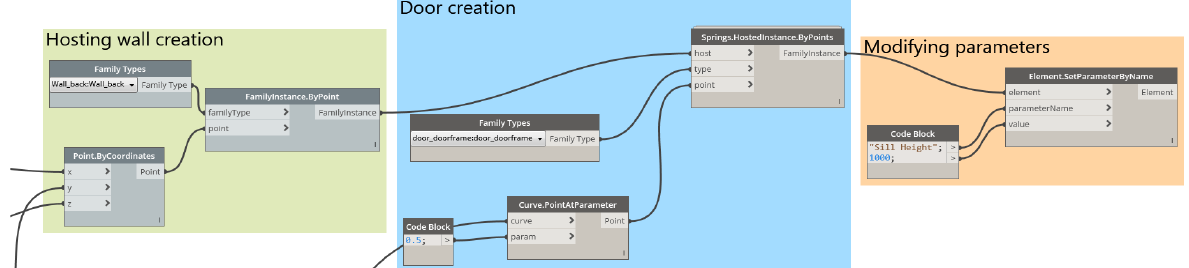
Fig. 4. Dynamo functions for the BIM modelling from